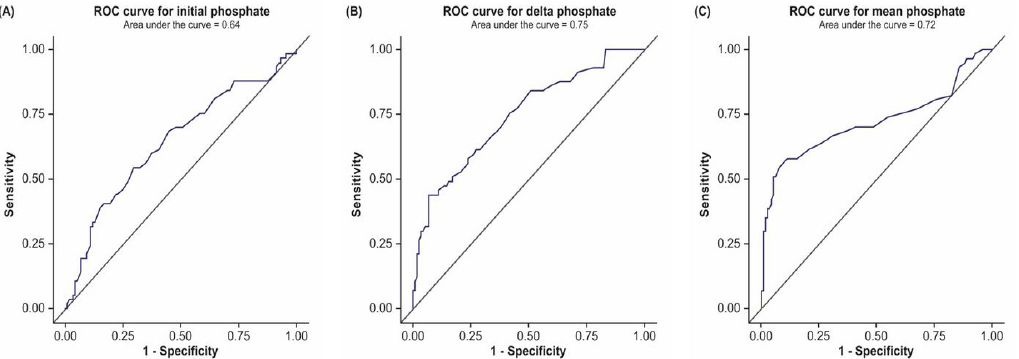
Figure 2. Receiver operating characteristic (ROC) curve according to phosphate metric categories. ( A ) Initial phosphate: the first phosphate value measured within 24 h of admission to the intensive care unit (ICU). ( B ) Delta phosphate: the range of change obtained by subtracting the minimum phosphate concentration from the maximum phosphate concentration measured during the ICU stay. ( C ) Mean phosphate: the arithmetical mean value for phosphate concentrations measured during the ICU stay. Table 3. Logistic regression analyses for phosphate categories in association with hospital mortality.